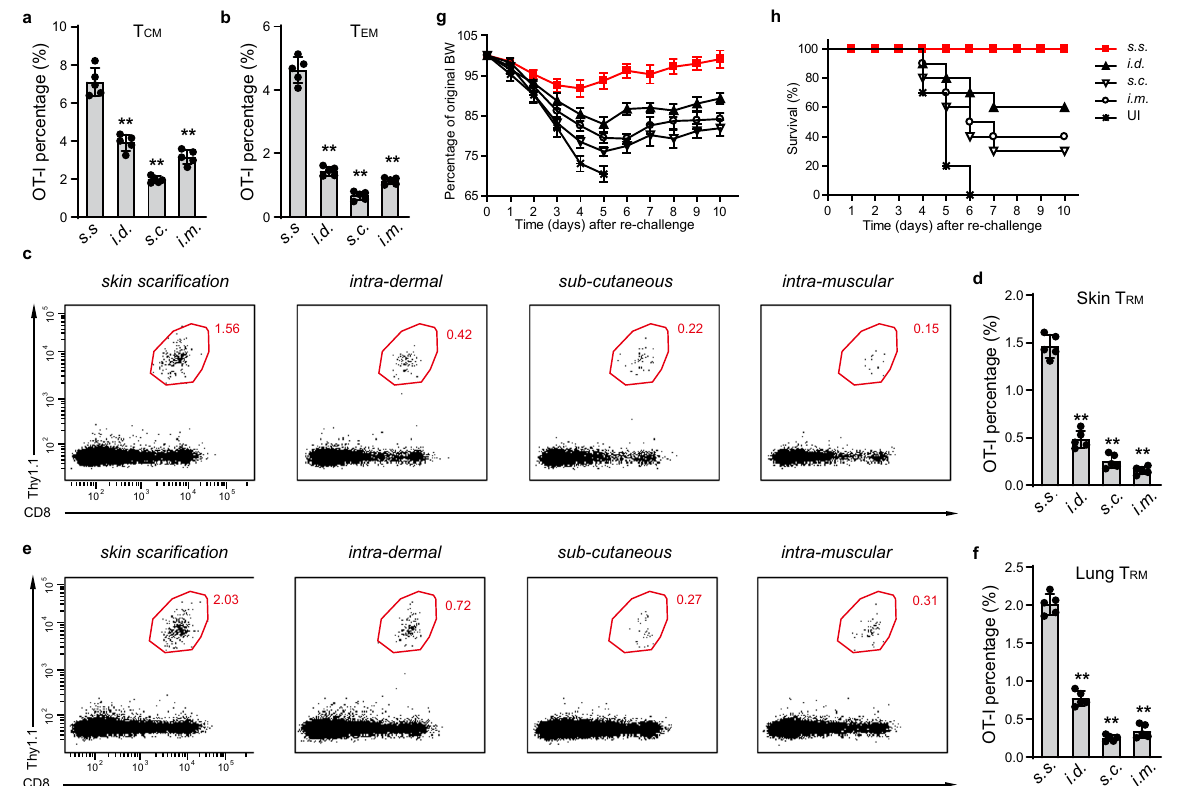
Fig. 3 Delivery of MVA via s.s. is superior in generating memory T cells and is superior in protecting mice against lethal respiratory challenge. a , b Quanti fi cation of OT-I T CM and T EM cells from spleen of mice at 45 days post MVA infection via indicated routes. c – f Flow cytometric analysis ( c , e ) and quanti fi cation ( d , f ) of OT-I T RM cells isolated from skin ( c , d ) or lung ( e , f ) tissue at 45 days post MVA infection via indicated routes. g , h Body weight (BW) ( g ) and survival measurements ( h ) of WR-VACV re-challenged mice that were previously immunized with MVA via indicated routes 45 days earlier. OT-I WT cells were adoptively transferred into µMT mice before mice were infected with 1.8 × 10 6 pfu MVA via indicated routes. 45 days later, mice were re-challenged with a lethal dose of WR-VACV by intranasal infection. c , e Data are representative of three independent experiments ( n = 5 mice per group). Graphs show the mean ± SD ( n = 5). UI = unimmunized. ** p <